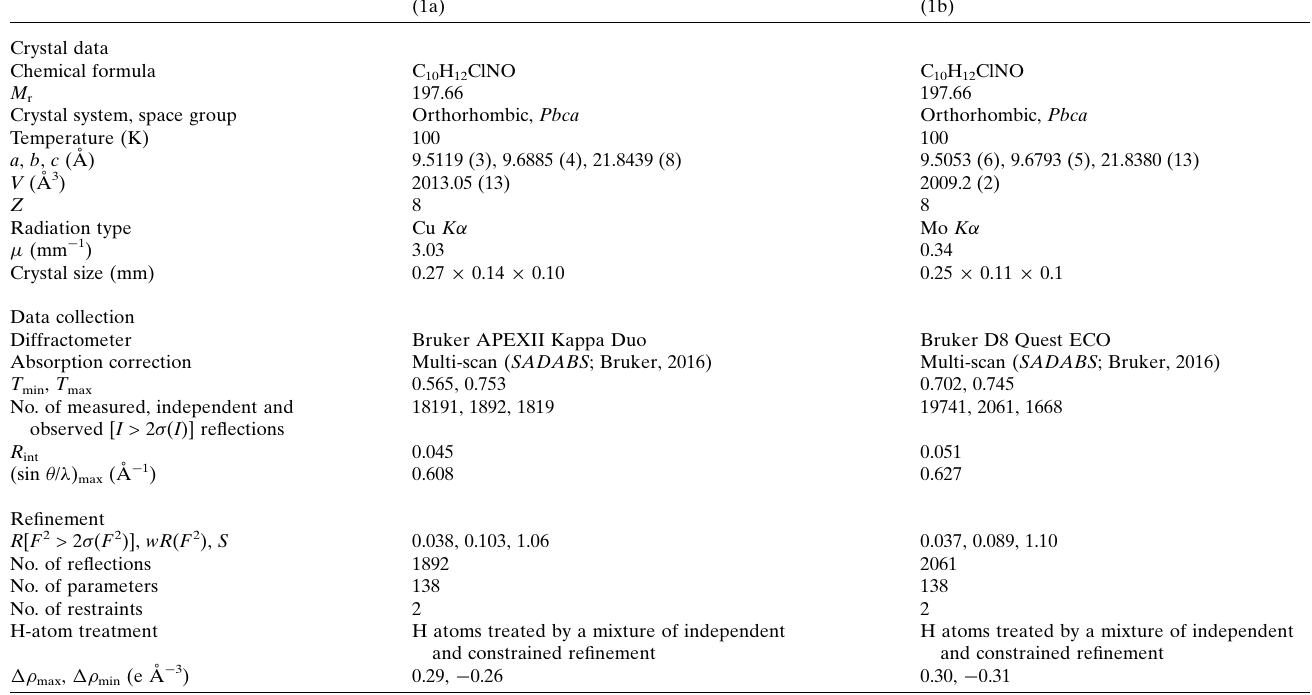
Table 4 Experimental